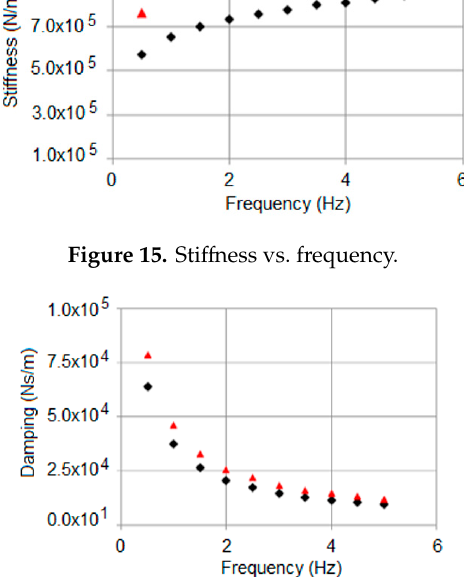
Figure 16. Damping vs. frequency.